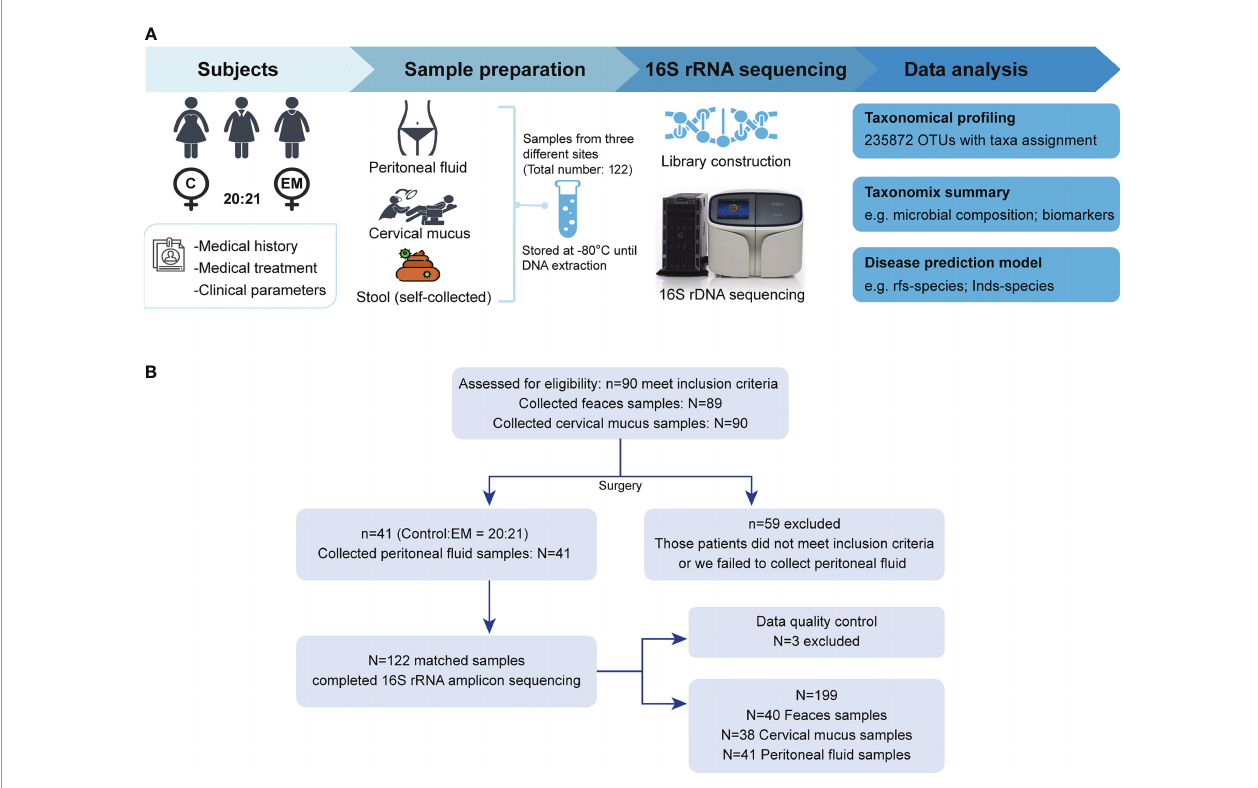
FIGURE 1 | Study design and participant screening. (A) Overview of the study design. (B) The fl ow scheme of participant